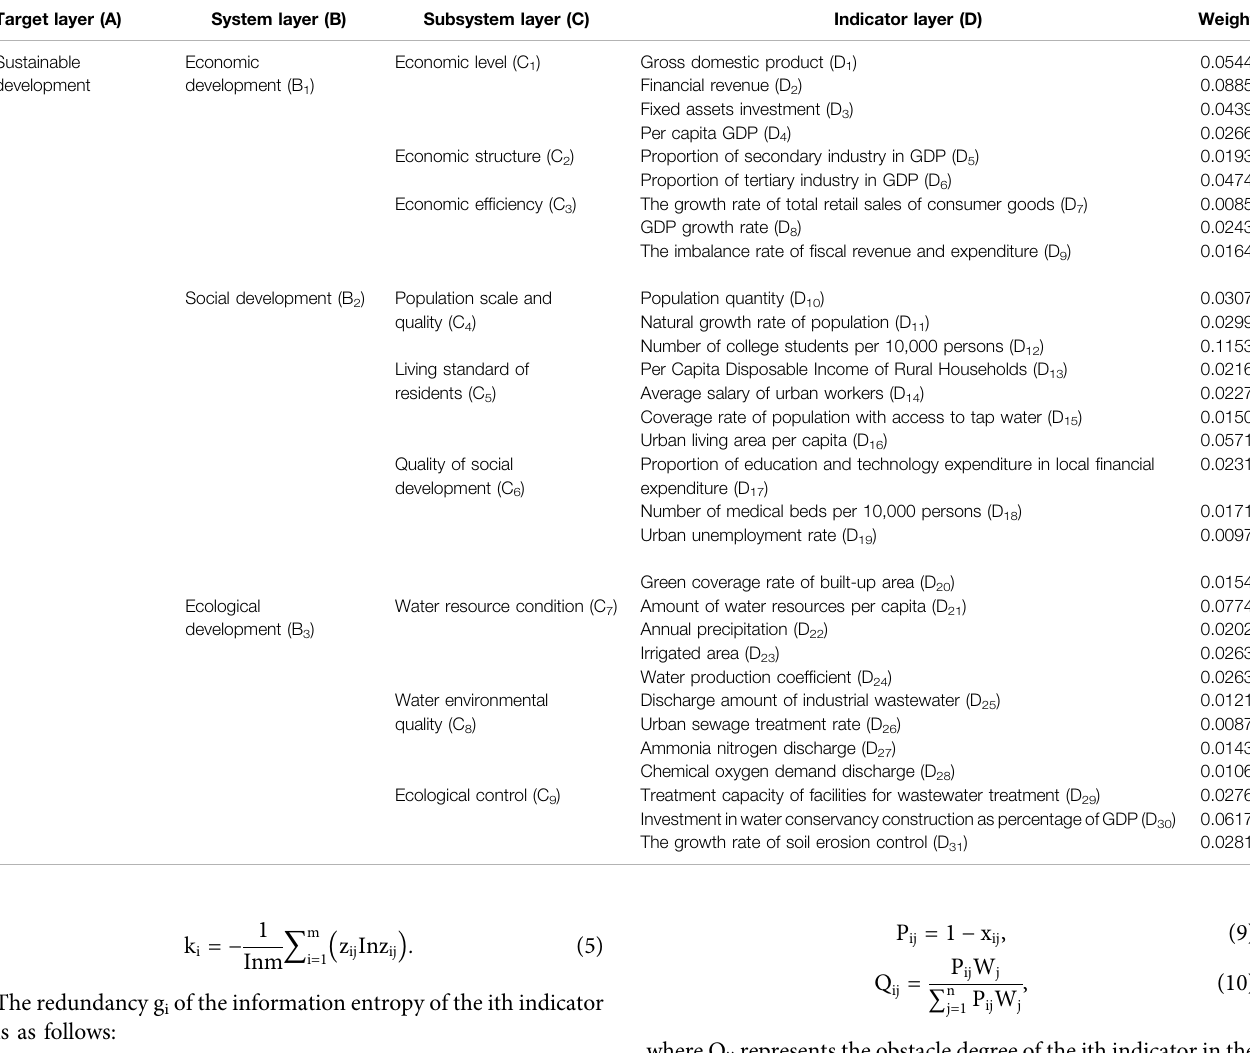
TABLE 1 | The evaluation indicator system of river basin sustainable